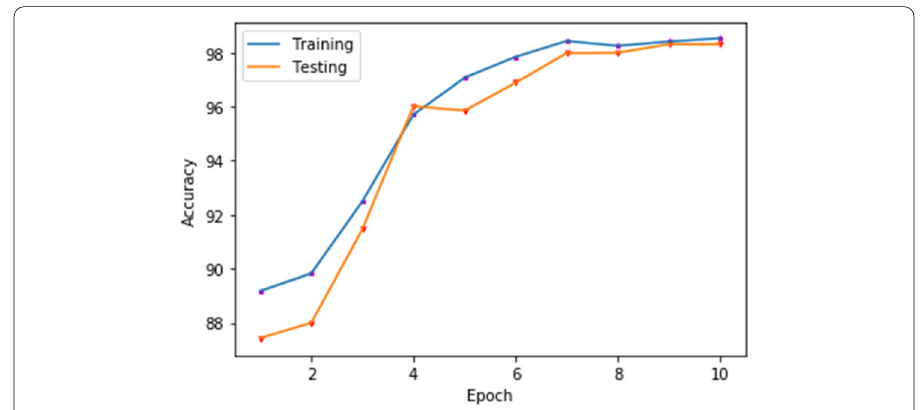
Fig. 7 Training and testing accuracy of proposed